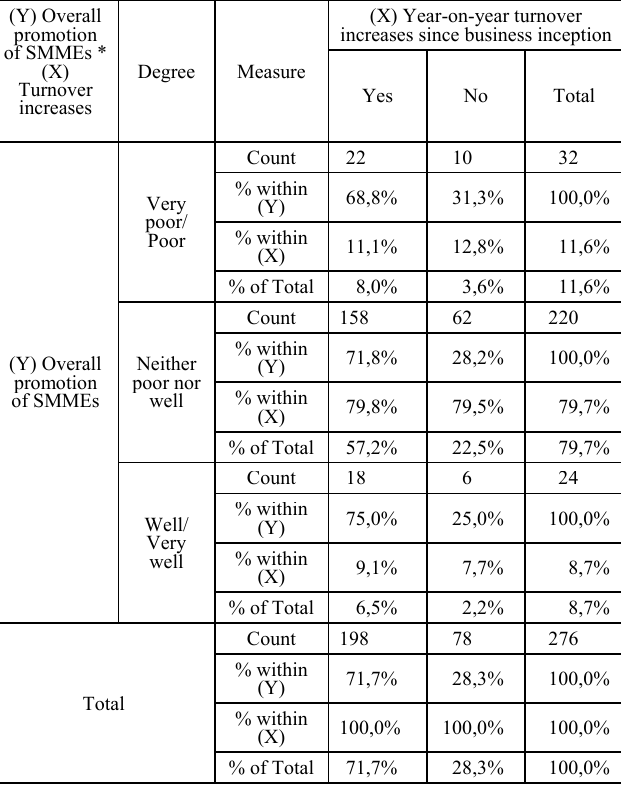
Table 12a: Promotion of SMMEs and turnover increases